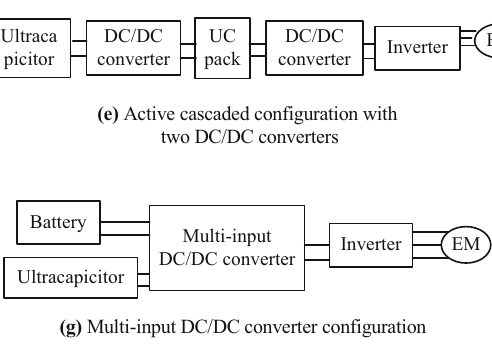
Fig. 5 Various possible configuration of UC and battery